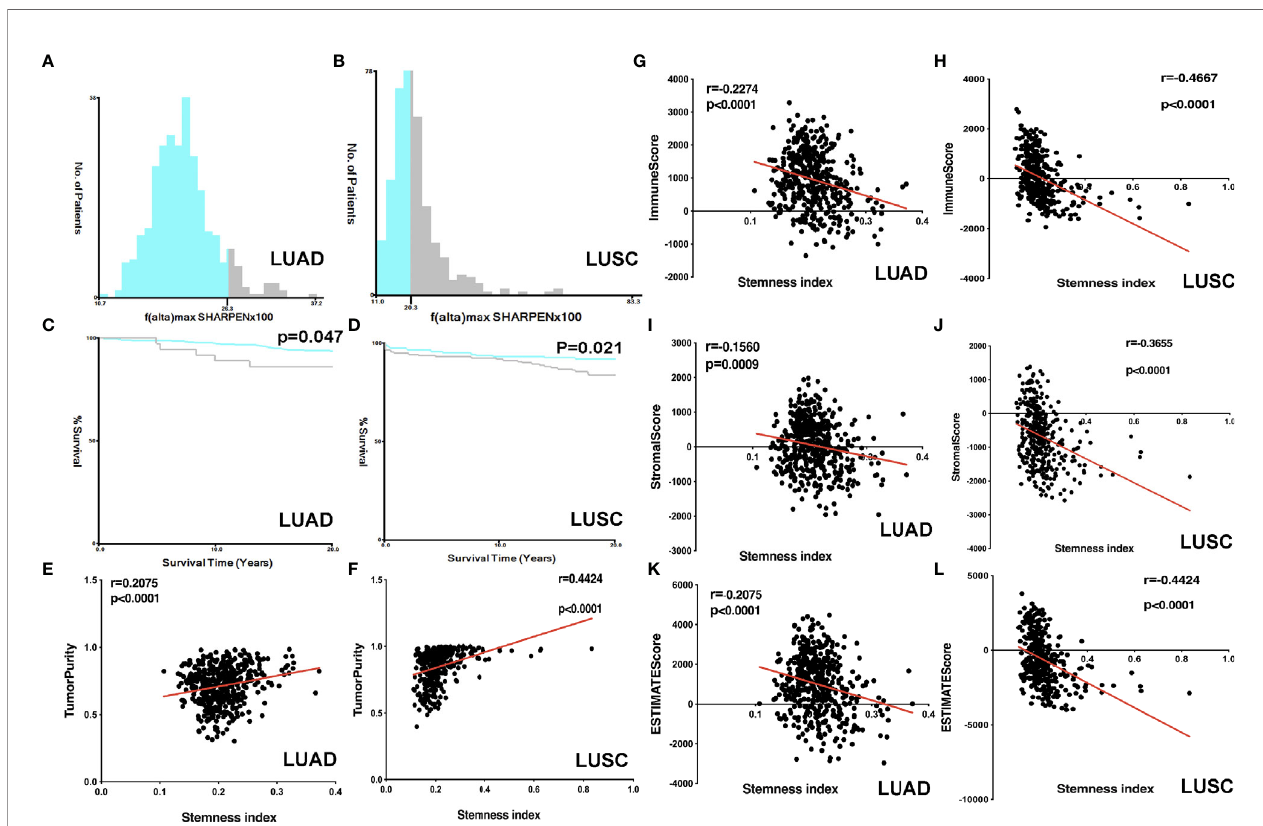
FIGURE 2 | Correlation analysis between ESTIMATE scores and mRNAsi. (A) The samples were divided into two groups with X-tile in LUAD (x = mRNAsi × 100 and y = number of patients). (B) The samples were divided into two groups with X-tile in LUSC (x = mRNAsi × 100 and y = number of patients). (C) Kaplan – Meier survival curves show that the low-mRNAsi group had a better OS rate than the high mRNAsi group in LUAD. (D) Kaplan – Meier survival curves show that the low mRNAsi group had a better OS rate than the high mRNAsi group in LUSC. (E) The correlation between tumor purity and mRNAsi in LUAD. (F) The correlation between tumor purity and mRNAsi in LUSC. (G) The correlation between immunescore and mRNAsi in LUAD. (H) The correlation between immunescore and mRNAsi in LUSC. (I) The correlation between stromalscore and mRNAsi in LUAD. (J) The correlation between stromalscore and mRNAsi in LUSC. (K) The correlation between ESTIMATEscore and mRNAsi in LUAD. (L) The correlation between ESTIMATEscore and mRNAsi in